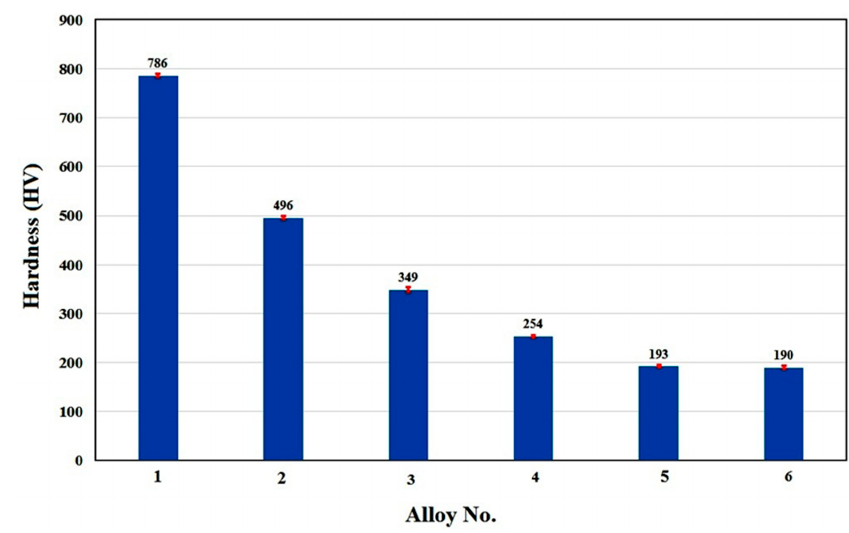
Figure 10. Microhardness of the as-cast six Fe–Mn–Ni–Cr–Al–Si HEAs.